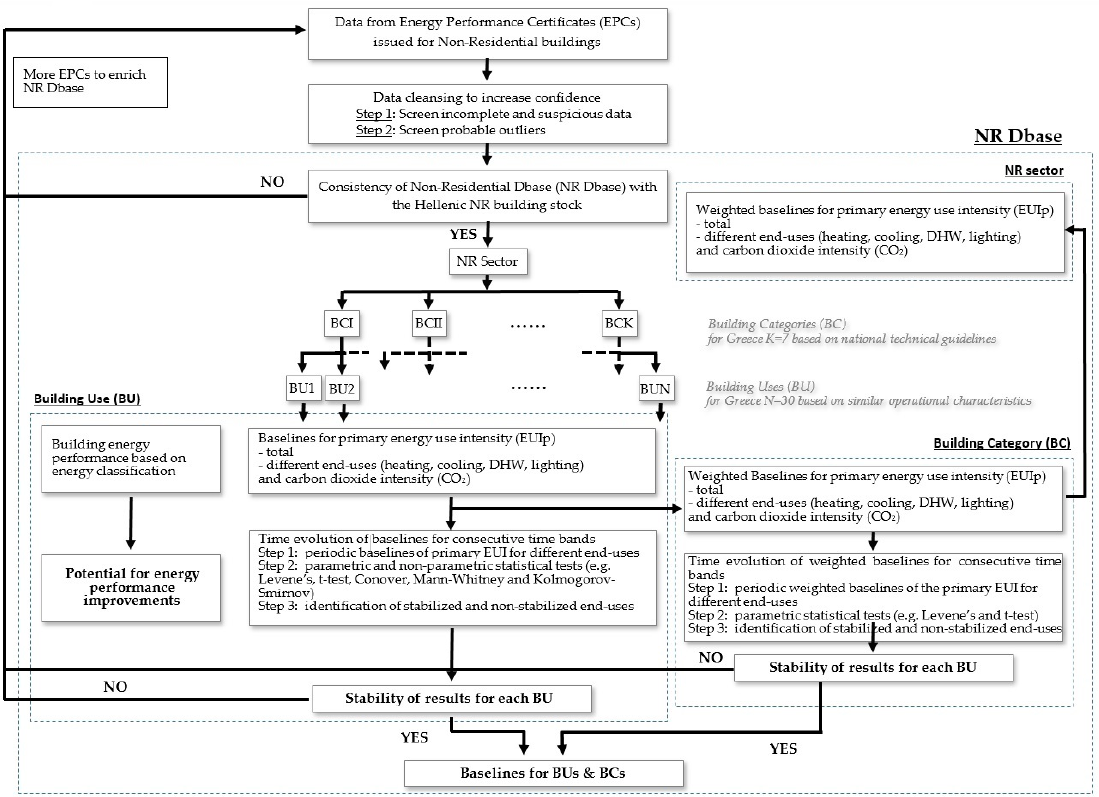
Figure 2. The main steps of the method.